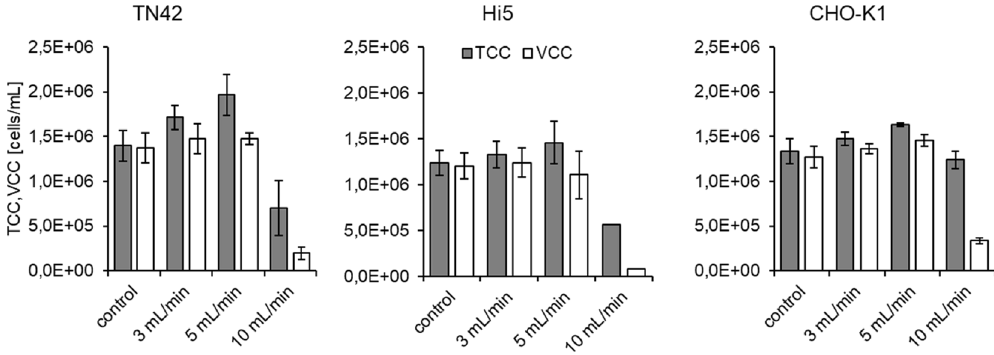
Figure 2. Total and viable cell counts after treatment with the shear device. Shear was measured at different flow rates for (left) TN42, (center) Hi5, and (right) CHO-K1 cells. Each run was performed in triplicate, except the Hi5 experiment (center) run at 10